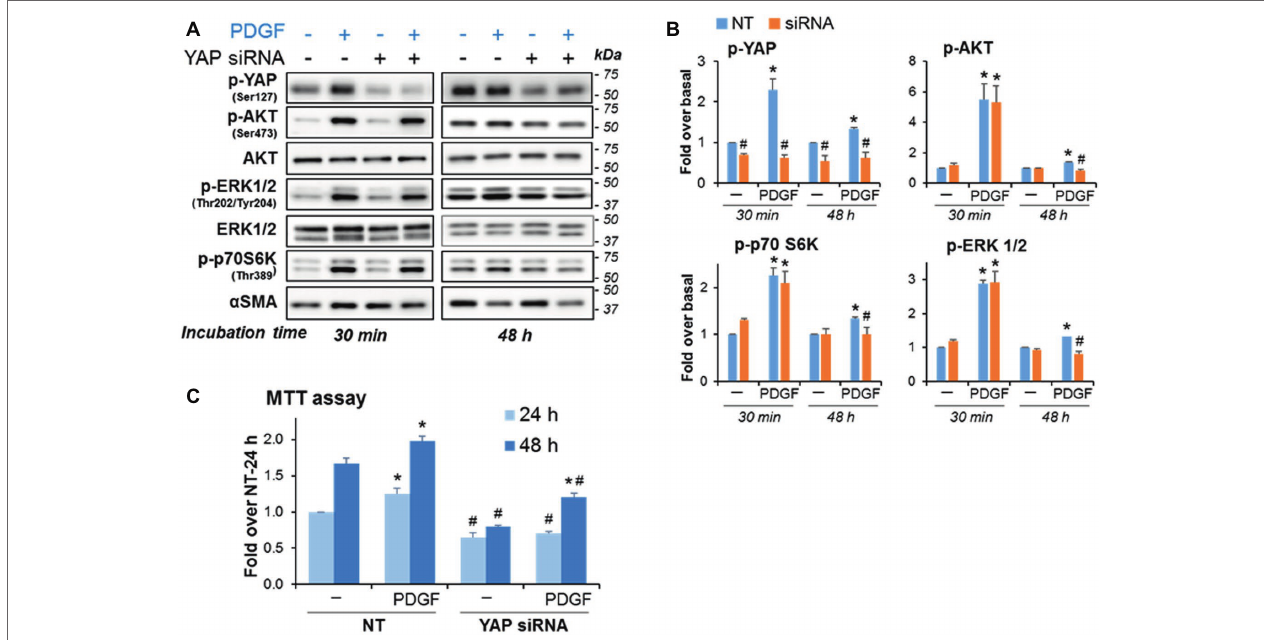
FIGURE 6 | YAP knockdown blunts the persistent activation of AKT and ERK induced by long-term stimulation with PDGF and reduces PDGF-induced proliferation in imPaSC. Mock and YAP-transfected cells were treated with 2 ng/ml PDGF for the indicated times. (A) Levels of phosphorylated and total AKT, ERK1/2 and p70S6K (a kinase in the mTOR pathway) were assessed by Western blotting. α SMA was tested as a marker of activation. (B) Graphs show optical density (OD) of the immunoblots depicted in panel A determined by densitometry. As indicated in the graphs, YAP knockdown did not affect PDGF-induced early activation of AKT, ERK1/2 and mTOR signaling but reduced the long-term (48 h) PDGF effects on growth signaling. (C) YAP siRNA treatment also reduced basal and PDGF-induced cell proliferation as indicated by MTT assay. Data in graphs are mean ± SEM; n = 3. * p < 0.05 vs. control ( − ); # p < 0.05 vs.